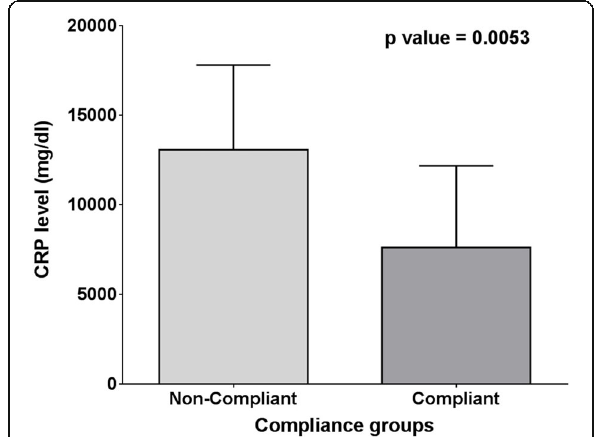
Fig. 7 Mean and SD of CRP compliance groups